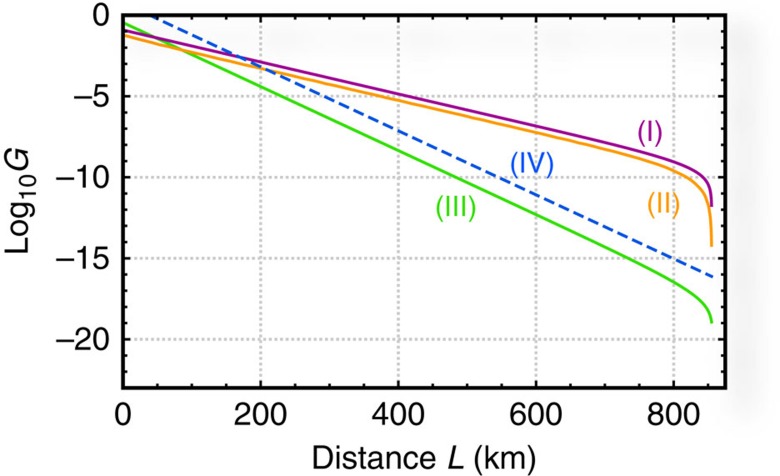
Secret key rates G per pulse versus distances L.G is normalized by the number of events of the same basis choice by Alice and Bob. Here ηs=0.90 (refs 40, 45, 46), τs=100 ps (ref. 47), ηd=0.93 (ref. 48), νd=1 s−1 (refs 48, 49), τa=67 ns (ref. 36), latt=22 km and c=2.0 × 108 m s−1. Lines (I)–(IV) represent our original protocol with steps (iii)–(v), our modified protocol with steps (iii')–(v'), the original mdiQKD protocol32 with the same single-photon sources and the TGW bound27
, respectively.